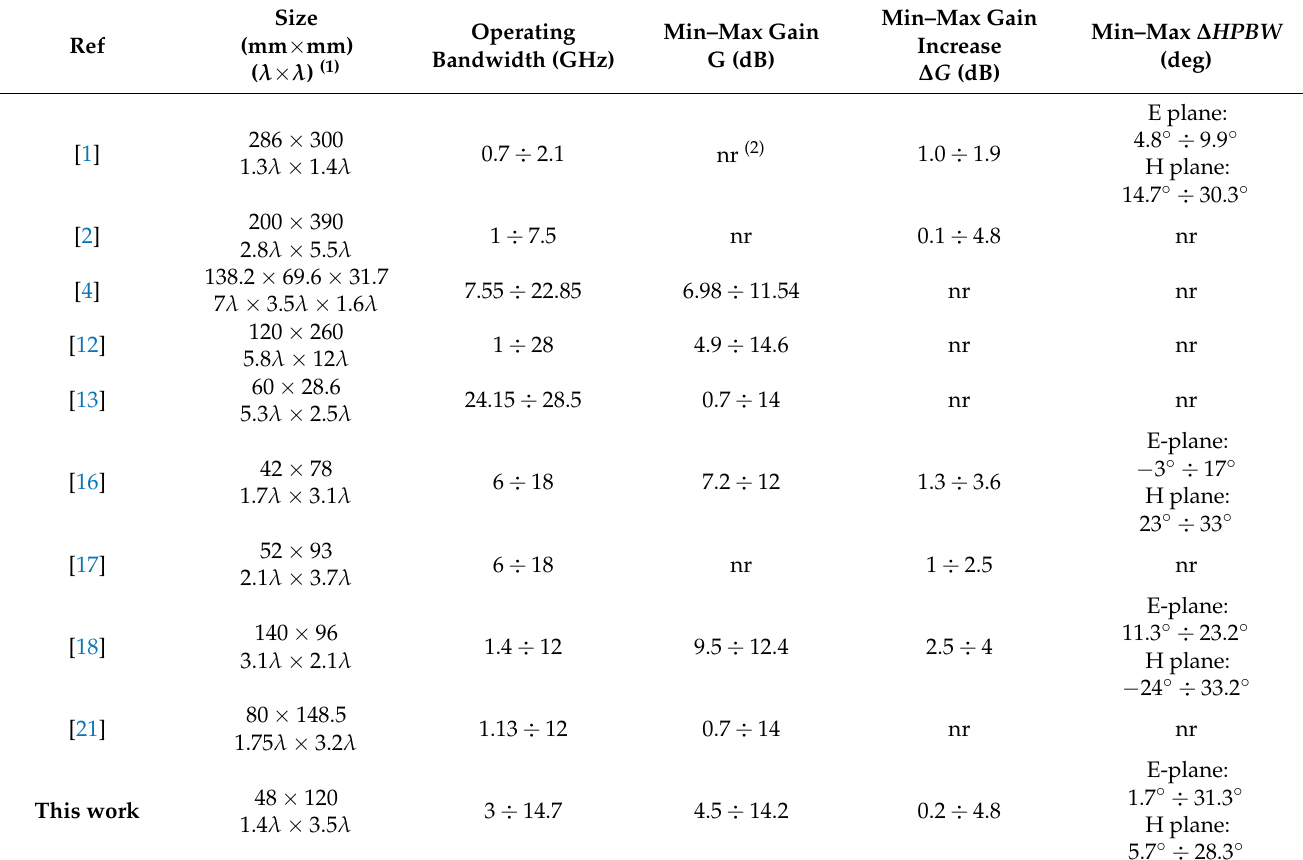
Table 3. Experimental results comparison of the metalens investigated in this work and similar published